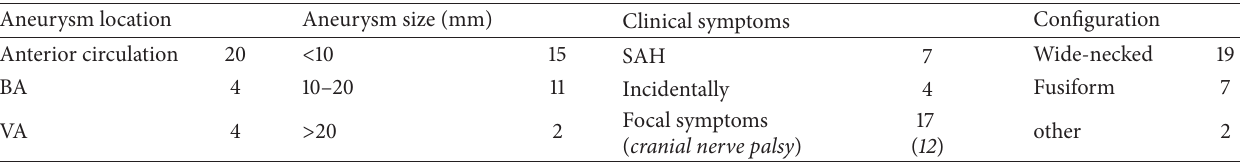
Table 1: Clinical